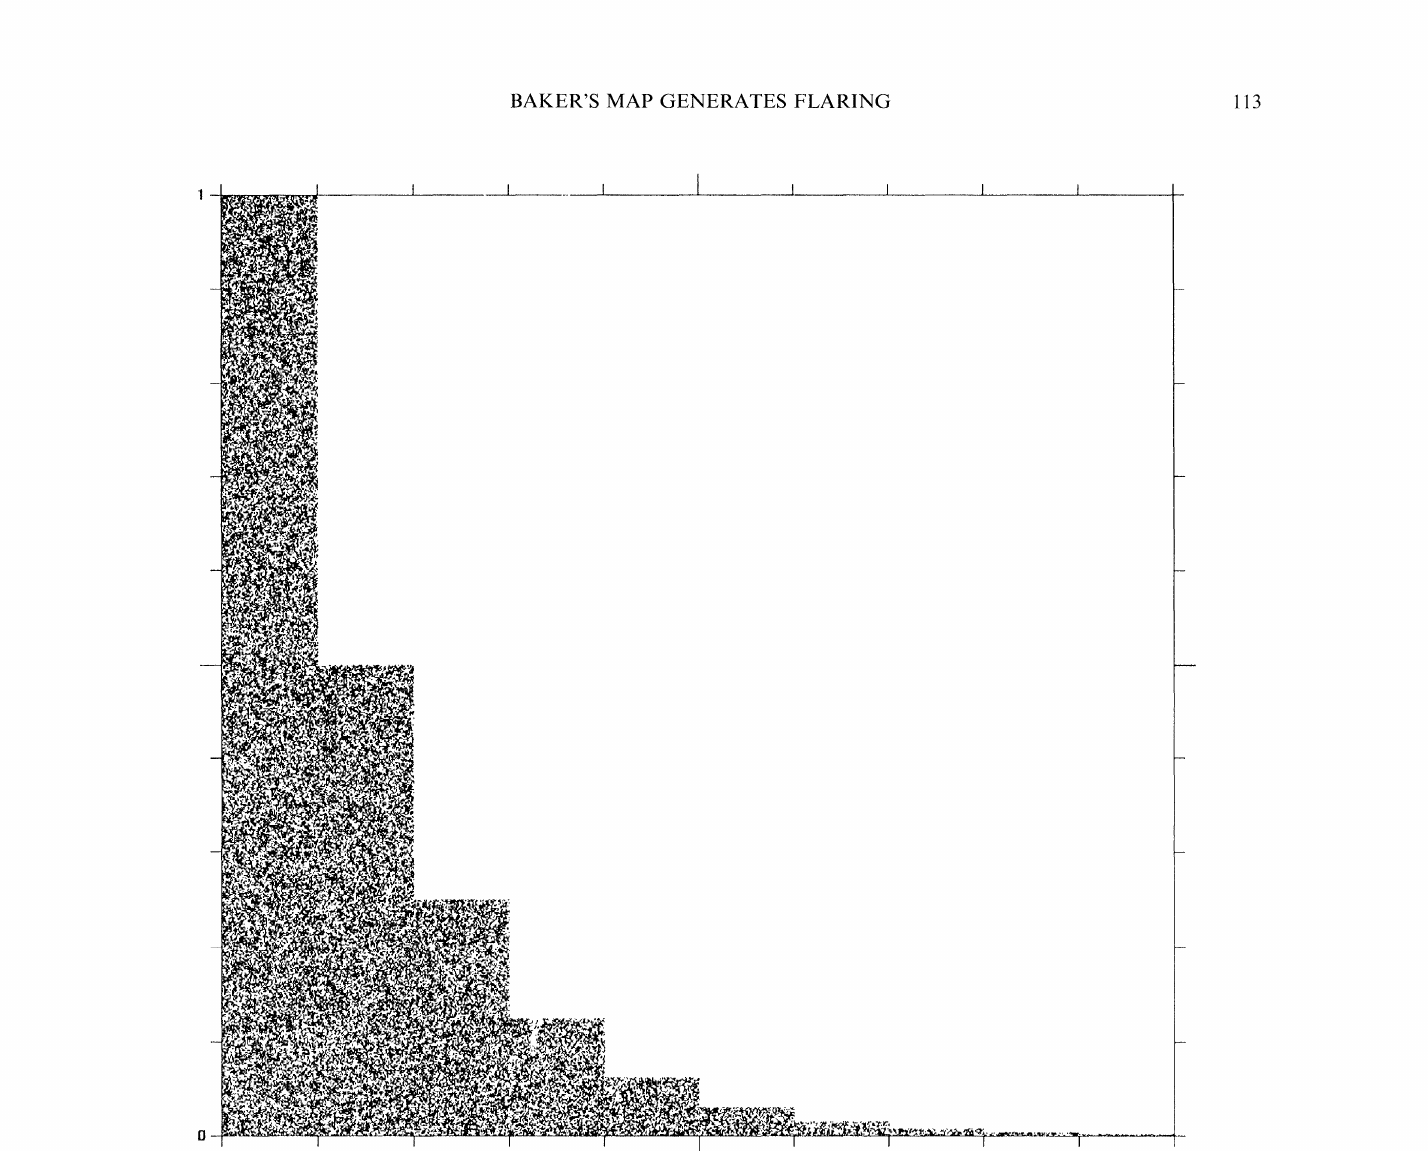
FIGURE 5 Staircase baker’s map, with the vertical height blown up tenfold. Numerical simulation of Eq. (3) using a 16-decimal- digits accuracy ("double precision"). 100 000 iterations; m 40. Only 10 stairs are